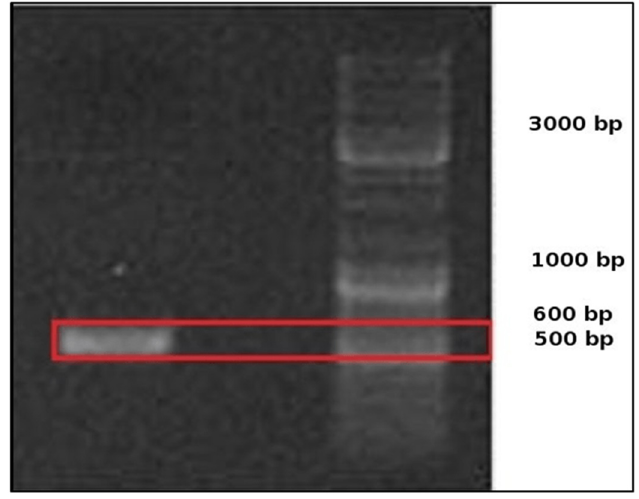
Figure 1. PCR amplification of tofu wastewater native yeast isolate in agarose gel. Table 2. BLAST results of native yeast isolate.